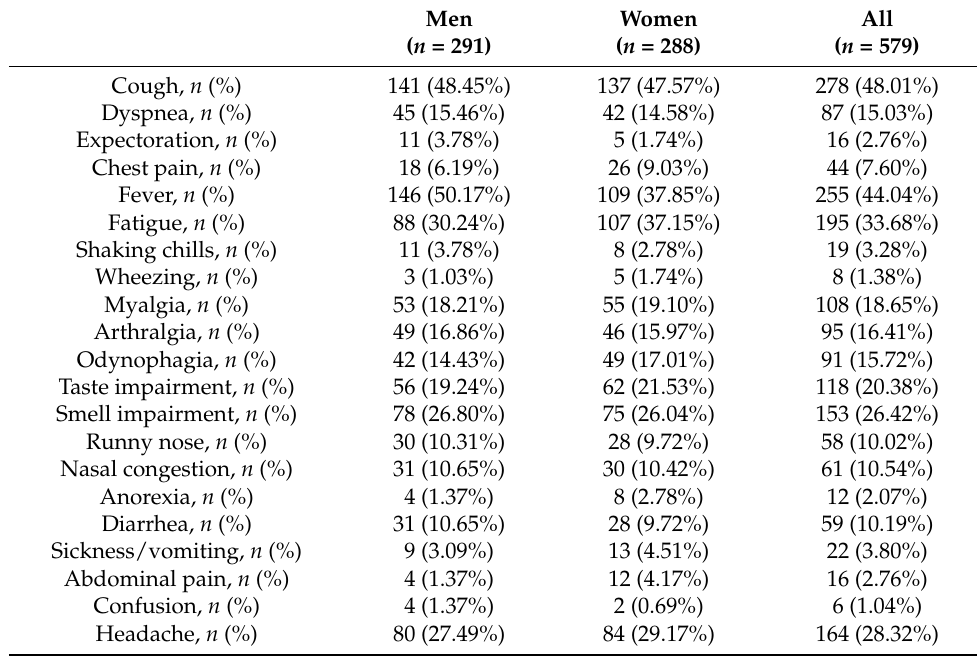
Table 2. List of most common symptoms in the acute phase of